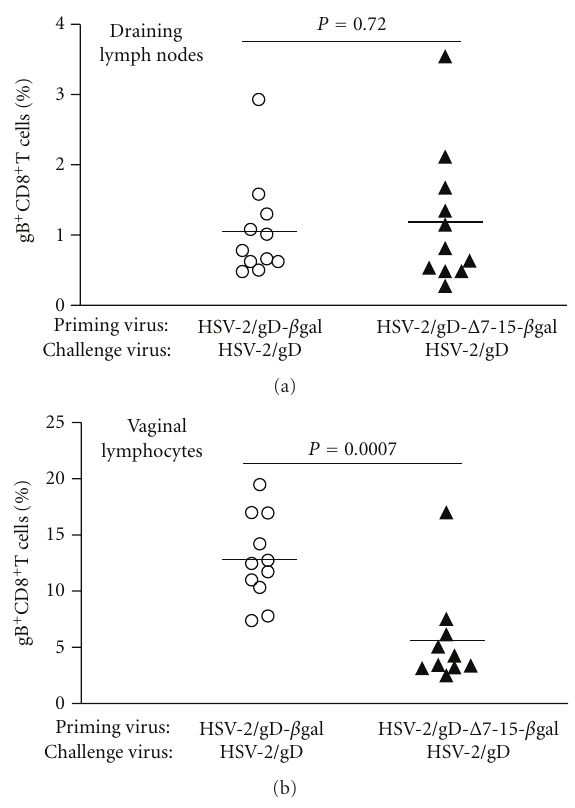
Figure 4: CD4 + T cell frequencies do not di ff er in draining lymph nodes (a) or vaginal mucosa (b) among lymphocytes isolated from groups of mice primed with viruses that can (HSV-2/gD- β gal, left, open circles) or cannot (HSV-2/gD- Δ 7-15- β gal, right, filled triangles) engage HVEM. Symbols show data from individual mice, with the horizontal line designating the mean for each experimental group. Data are pooled from three independent experiments with 3-4mice per